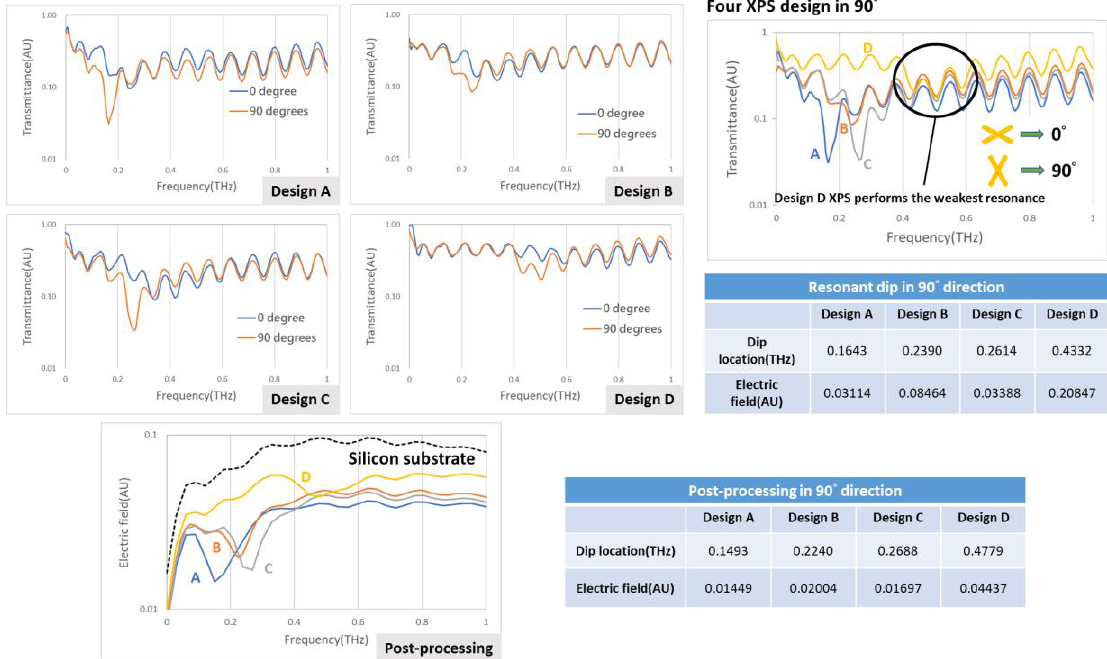
Figure 4. E ff ect of four XPS designs in an actual situation; all perform best in direction 90 ◦ .